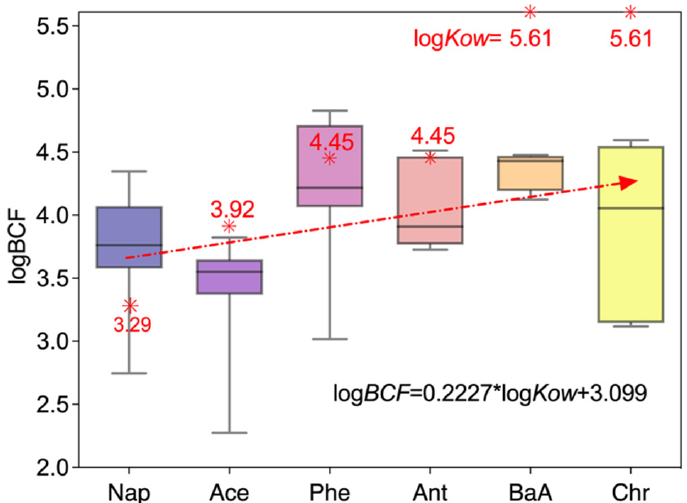
Figure 6. The bioconcentration factors (BCF) of PAHs from water to phytoplankton and the linear equation between logBCF and log Kow of PAHs. Note: (1) * and the red text shows the log Kow of different PAHs. (2) Naphthalene (Nap), acenaphthylene (Ace), phenanthrene (Phe), anthracene (Ant), benzo[a]anthracene (BaA), and chrysene